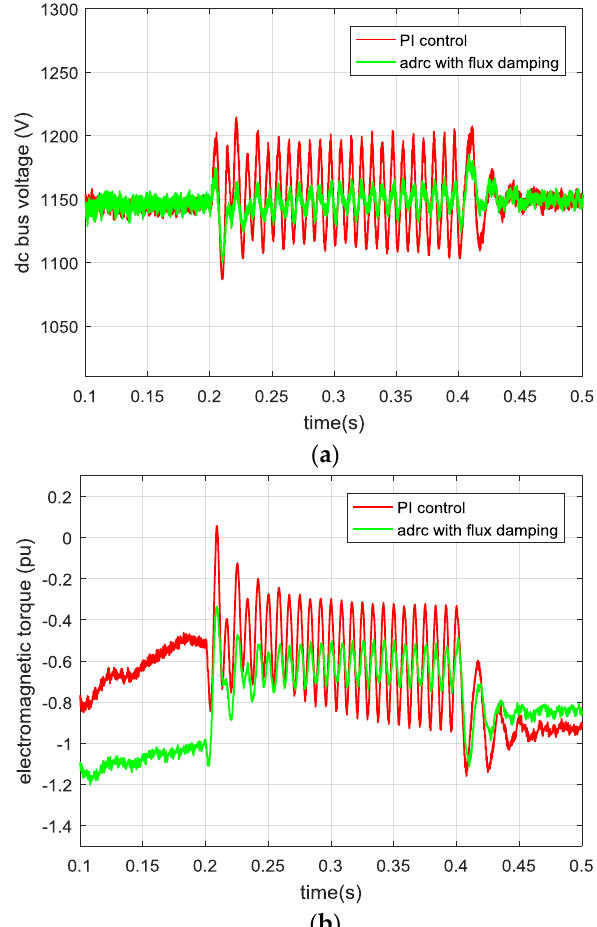
Figure 12. Asymmetrical 80% voltage dip case: ( a ) DC bus voltage and ( b ) electromagnetic torque.